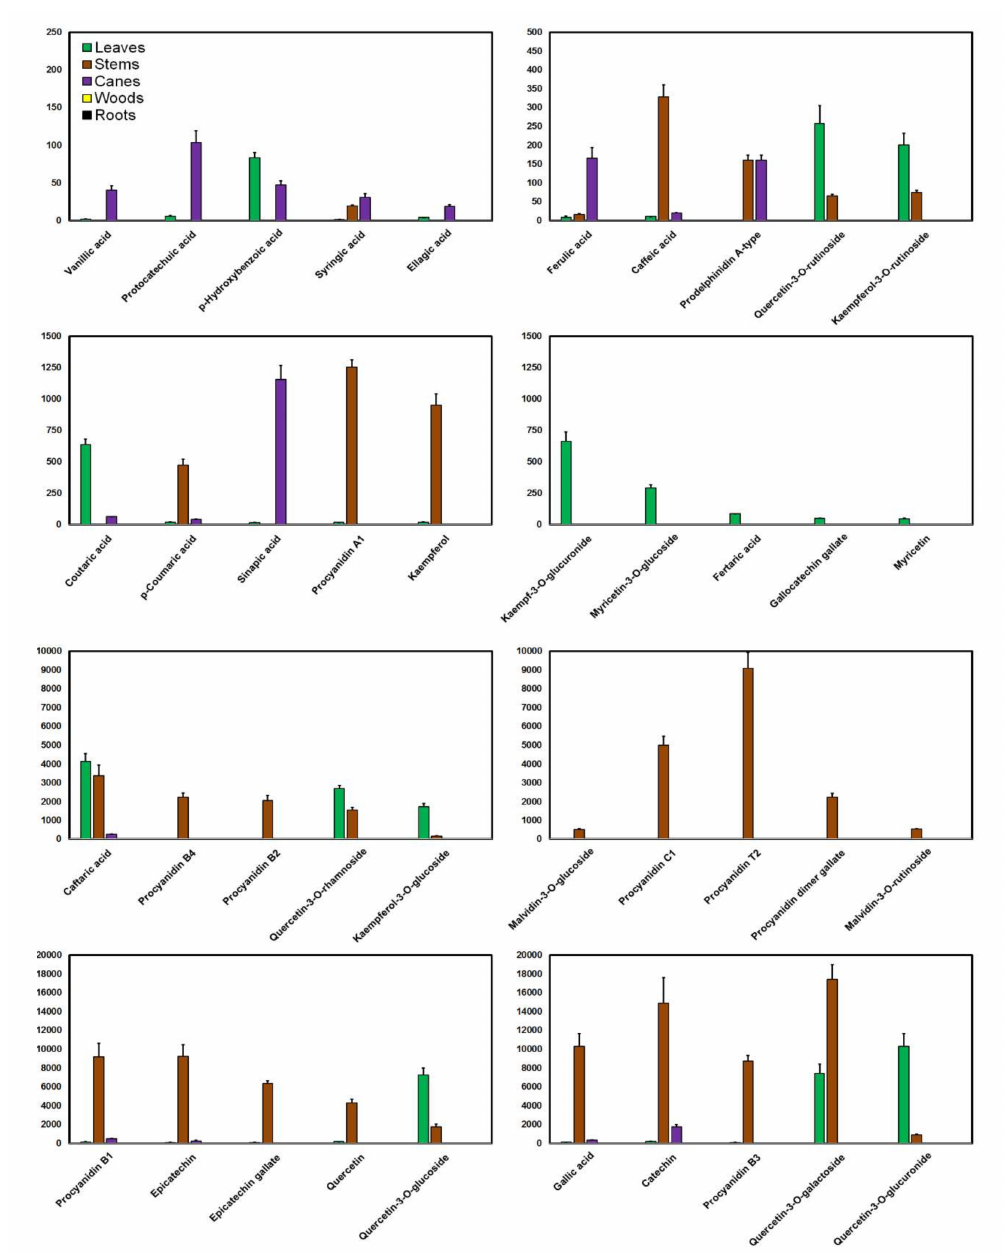
Figure 1. Distribution of the major phenolic acids and flavonoids in the vegetative organs of the vine plant: mean values ( y -axis; mg / kg) + standard deviations as error bars divided by 10 for better